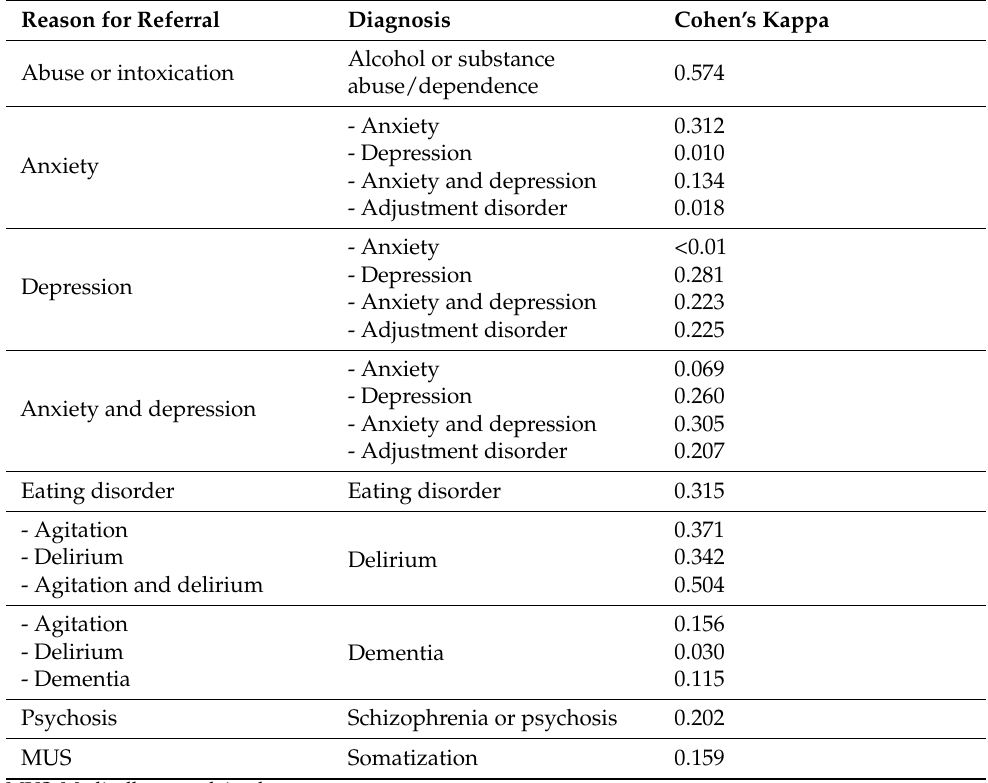
Table 2. Overall agreement on primary psychiatric diagnoses by CL psychiatrists and treating physi-